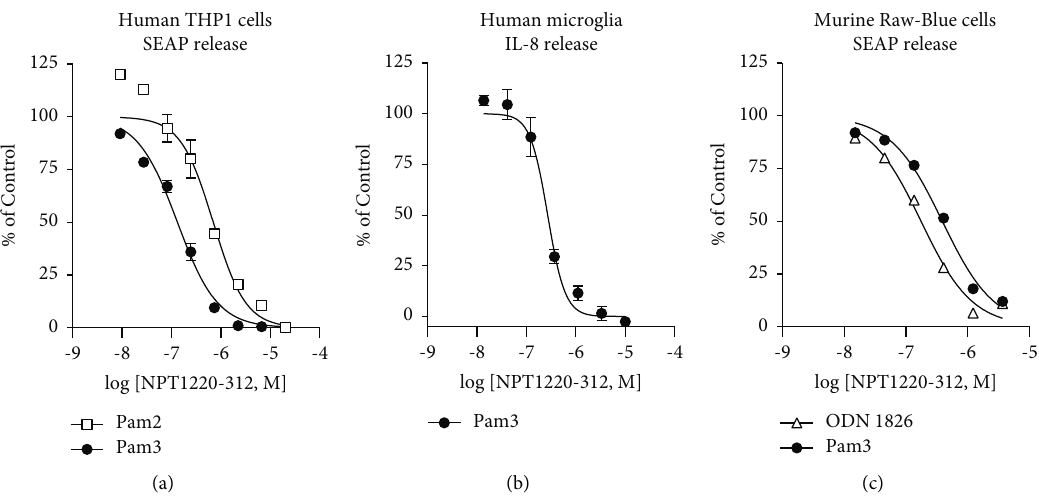
Figure 4: NPT1220-312 blocks TLR2 and TLR9 activation in peripheral and central immune cells. NPT1220-312 blocked: (a) Pam and Pam 3 CKS 4 -evoked release of SEAP in human THP1 cells, (b) Pam 3 CKS 4 -evoked release of IL-8 in human microglia, and (c) Pam 3 CKS 4 - evoked release of SEAP- and ODN1826-evoked release of SEAP in murine RAW-Blue